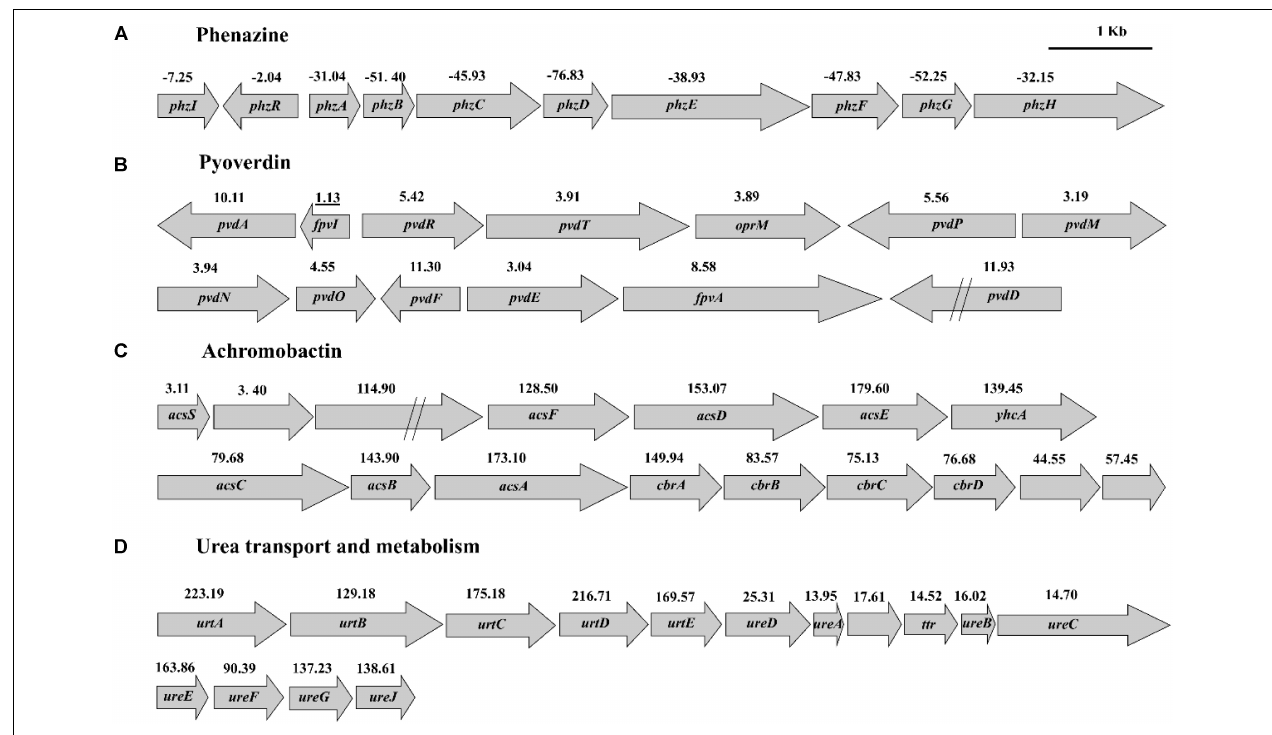
FIGURE 5 | Transcription levels of gene clusters of PCN synthesis (A) , pyoverdin synthesis (B) , achromobactin synthesis (C) , and urea transport and metabolism (D)